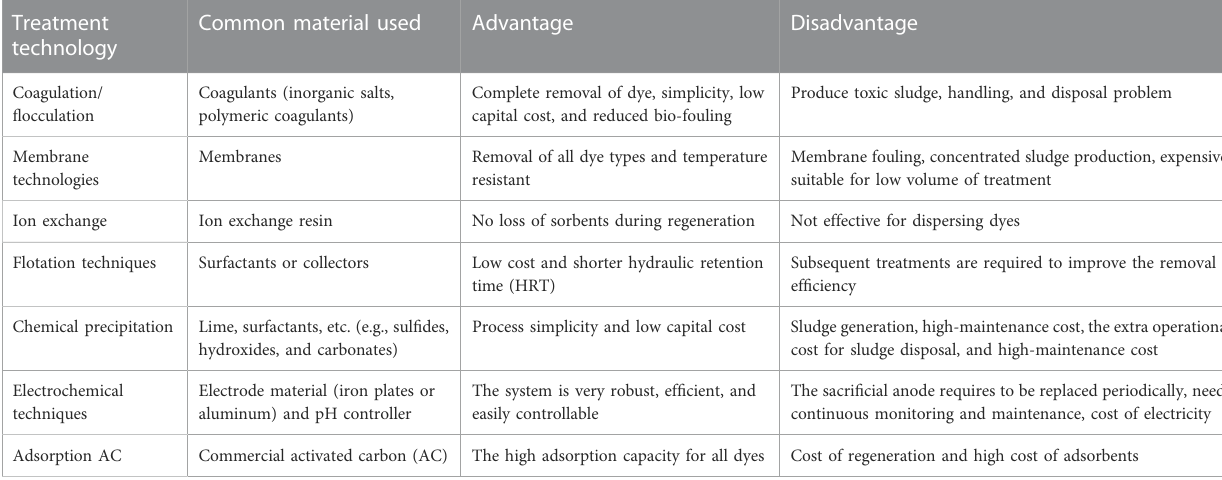
TABLE 3 Merits and demerits of various textile wastewater treatment techniques (Collivignarelli et al., 2019; Aragaw and Bogale, 2021; Yeow et al., 2021). Treatment technology